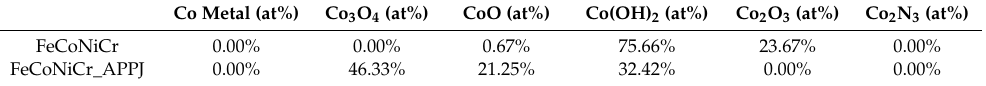
( b ) Figure 10. XPS Ni2p spectra of ( a ) FeCoNiCr and ( b ) APPJ-treated FeCoNiCr MEAs. Table 6. XPS Ni2p deconvoluted peak areal ratios from XPS spectra shown in Figure 10. Ni (at%)